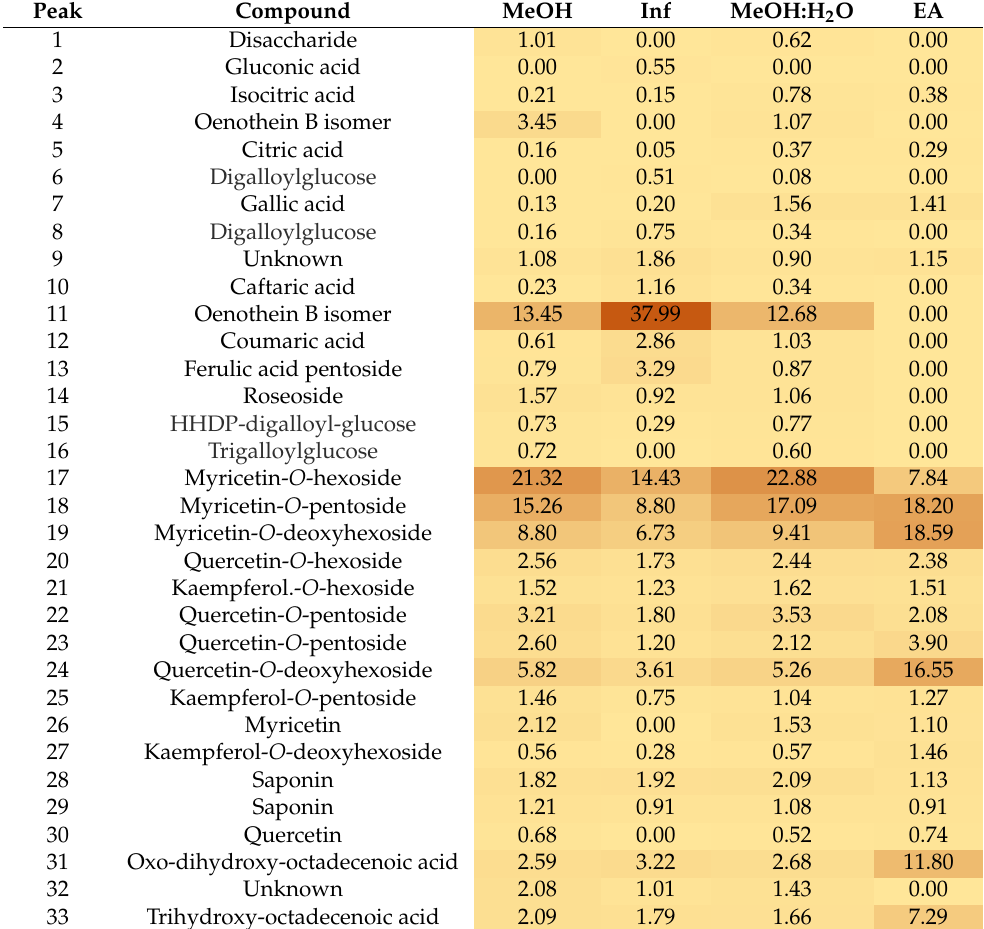
Table 3. Relative peak areas and heat map of extracts of the aerial parts of Epilobium hirsutum *.